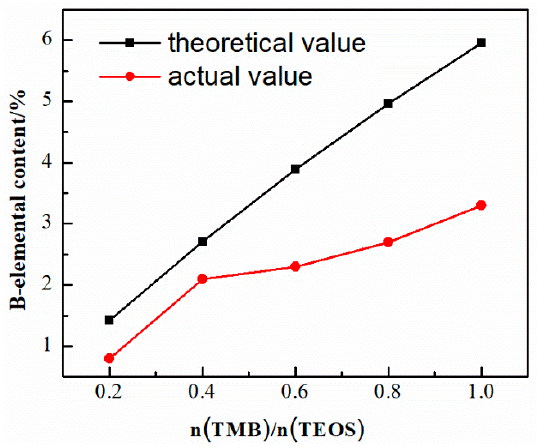
Figure 4. Boron element content of SiBCO aerogel with various TBM dosages.